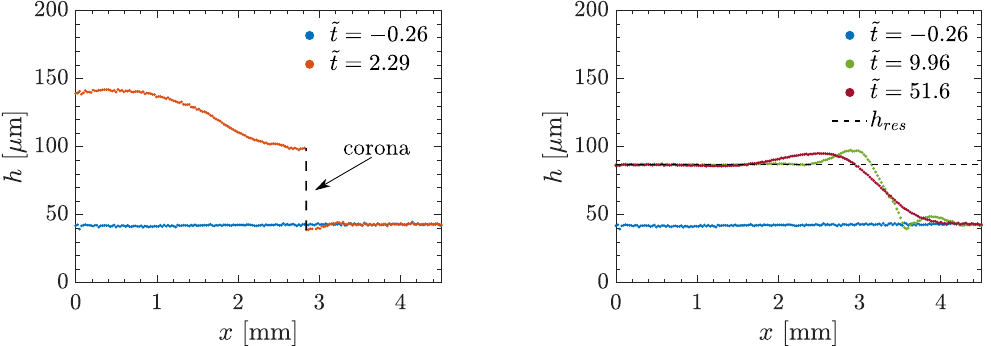
Figure 3. S10 drop impacting onto a S10 film. Film thickness h measured with the CLS at different dimensionless times before (blue markers) and after the impact. Impact Parameters: U = 3.95 m/s, D = 1.55 mm, H f = 42 µ